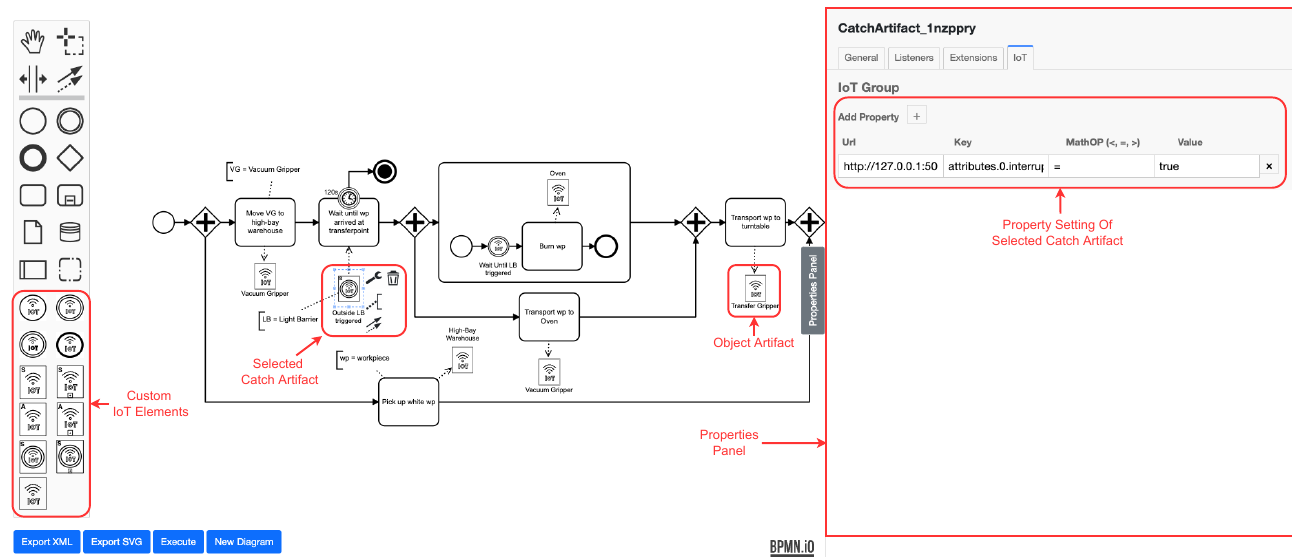
Figure 15. Modeling and configuring IoT-driven process with the modeling